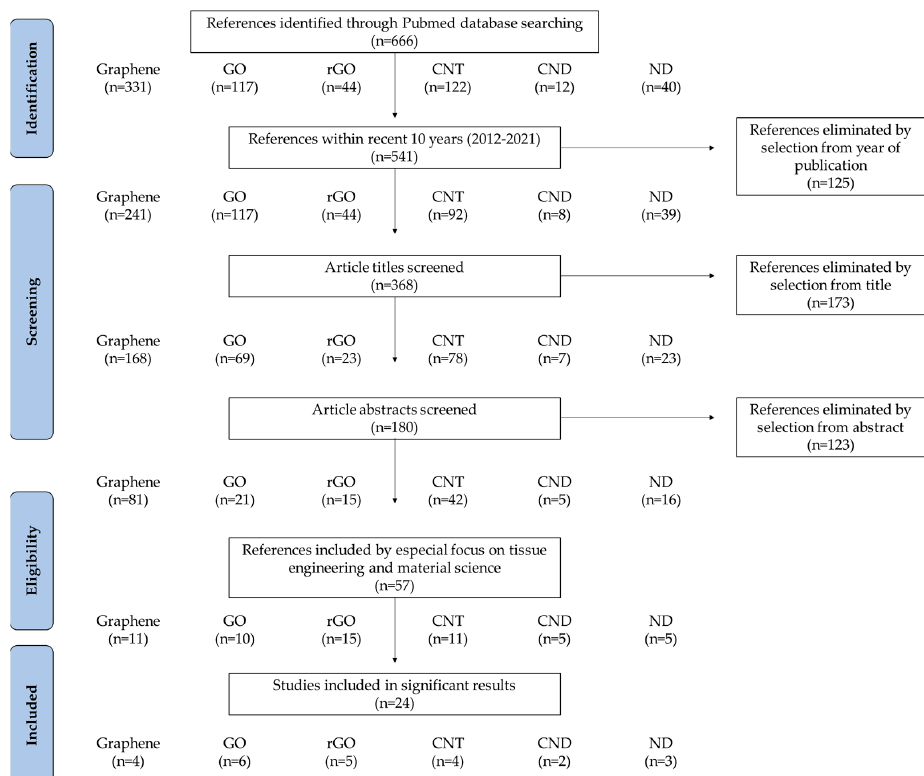
Figure 2. PRISMA flow diagram denoting literature search